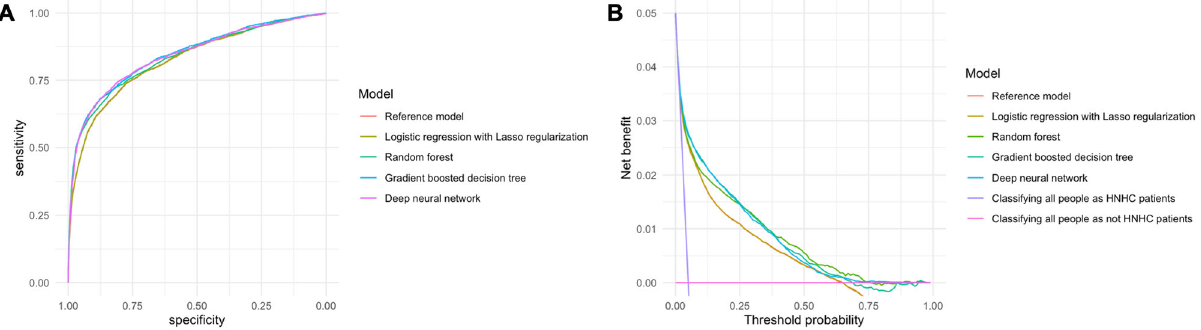
Fig. 2 Prediction ability of the reference and machine-learning-based prediction models for HNHC patients. A Receiver-operating- characteristics (ROC) curves. The corresponding values of the area under the receiver-operating-characteristics curve for each model (i.e., the c-statistics) are presented in Table 2. B Decision curve analysis. The X -axis indicates the threshold probability for HNHC patients. The Y -axis indicates the net bene fi t. The curves (decision curves) indicate the net bene fi t of models (the reference model and four machine-learning- based models) as well as two clinical alternatives (classifying no people as HNHC patients vs. classifying all people as HNHC patients) over a speci fi ed range of threshold probabilities of outcome. Compared to the reference model, the net bene fi t, which is de fi ned as the following equation, for all machine-learning-based models was greater across the range of threshold probabilities. “ net bene fi t = (1 − false negative) × prevalence − false positive × (1 − prevalence) × the odds at the threshold probability ” . HNHC patients = high-need, high-cost